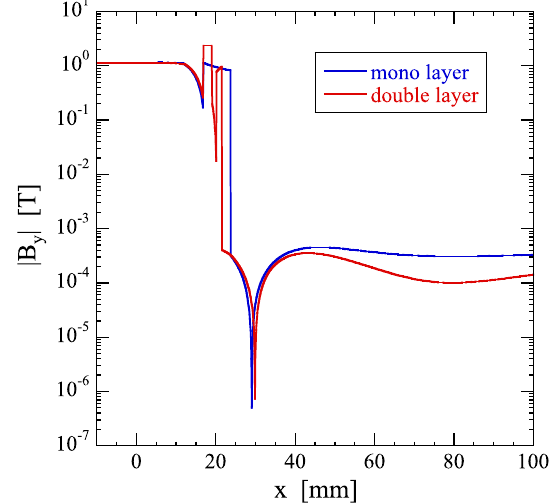
FIG. 17. Transverse distribution of magnetic flux density at the longitudinal center (z ¼ 0 mm) of the dc septum. Blue line represents the simulated distribution for the original 7-mm-thick mono layer and red line represents that for 4.8-mm-thick double layer